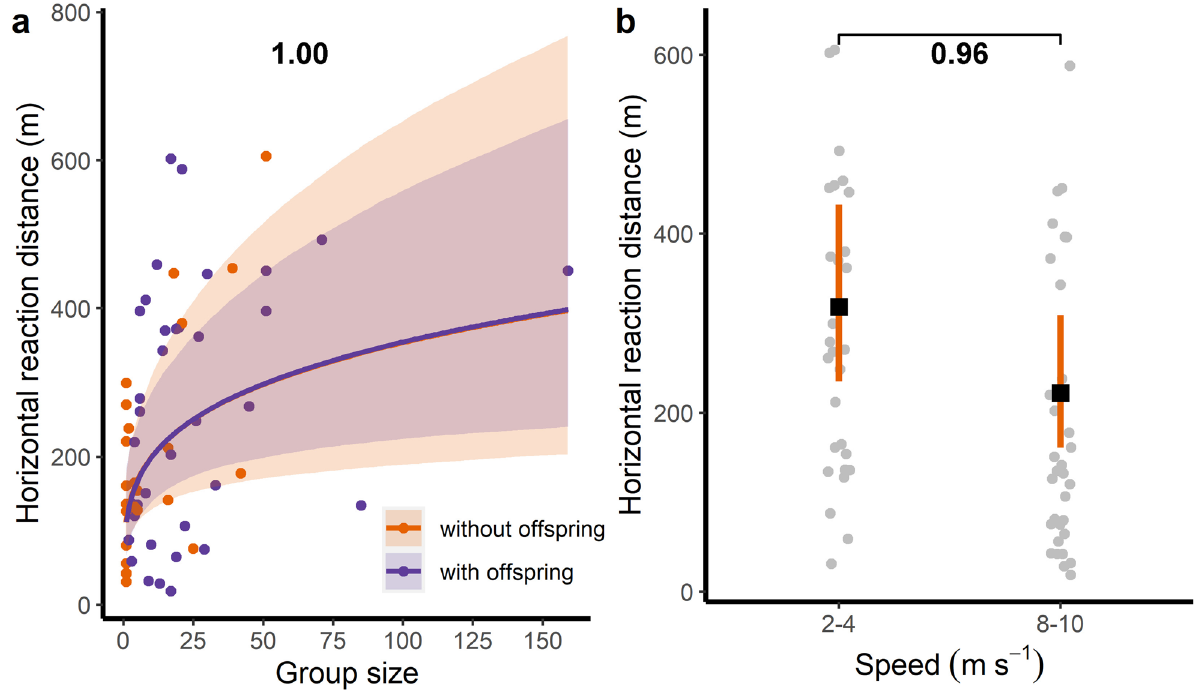
Figure 3. Relationship between the horizontal reaction distance (rd) and ( a ) group size, with and without offspring, and ( b ) flight speed, during experimental drone flights. Colour lines and black squares represent mean estimates of the models; colour bands and vertical bars represent the 95% CrI. Dots represent raw data, horizontally jittered in the case of ( b ). Numbers represent the posterior probability of a mean difference between compared estimates. A statistically meaningful effect (presented in bold) can be assumed when the posterior probability of the mean difference between compared estimates is higher than 0.95.